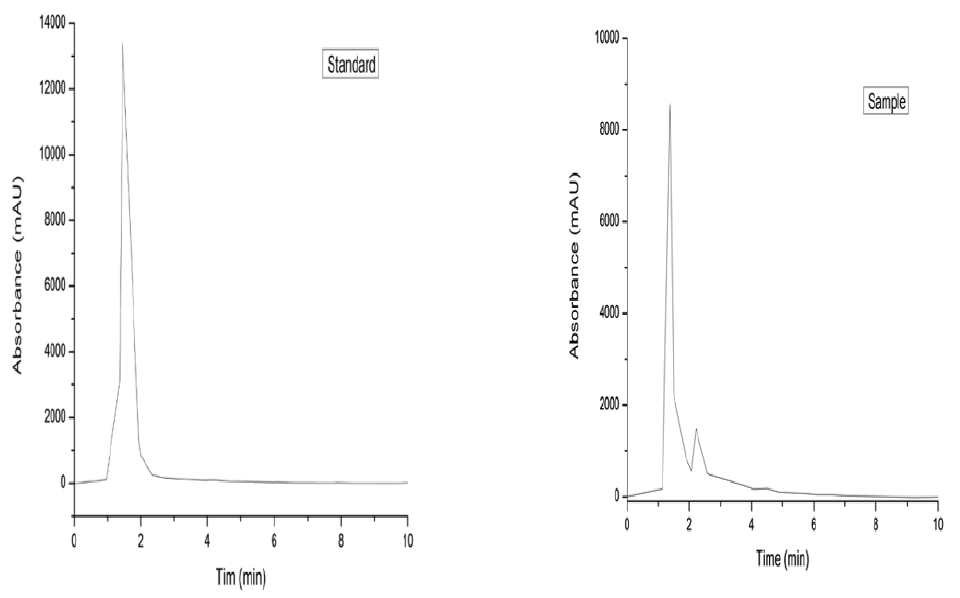
Figure 10. Chlorophyll purity t evaluated by HPLC at 13,500 mAU.